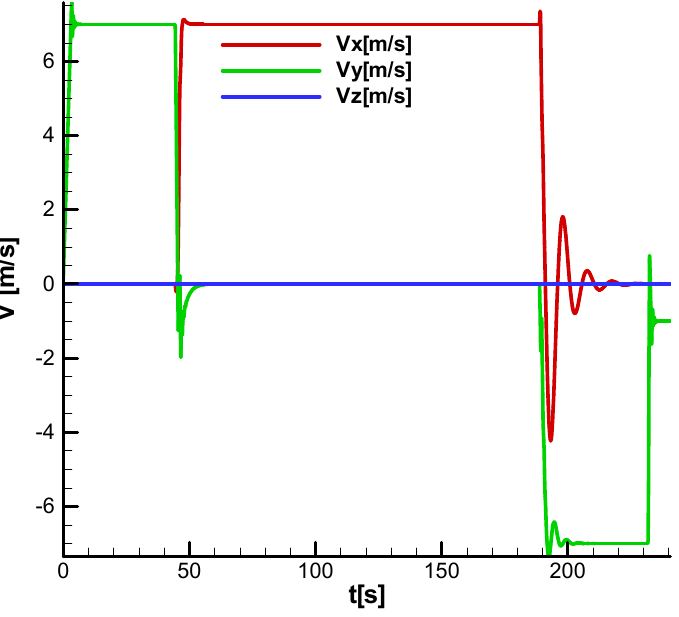
Figure 21. Velocity components along the local frame.